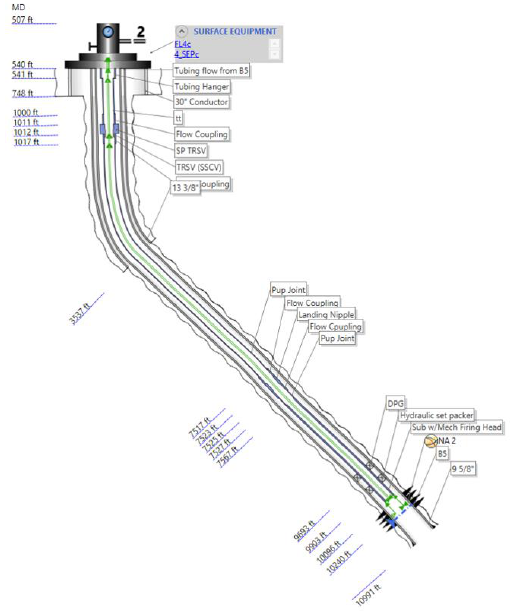
Figure 5. Target well schematic for the PIPESIM model.